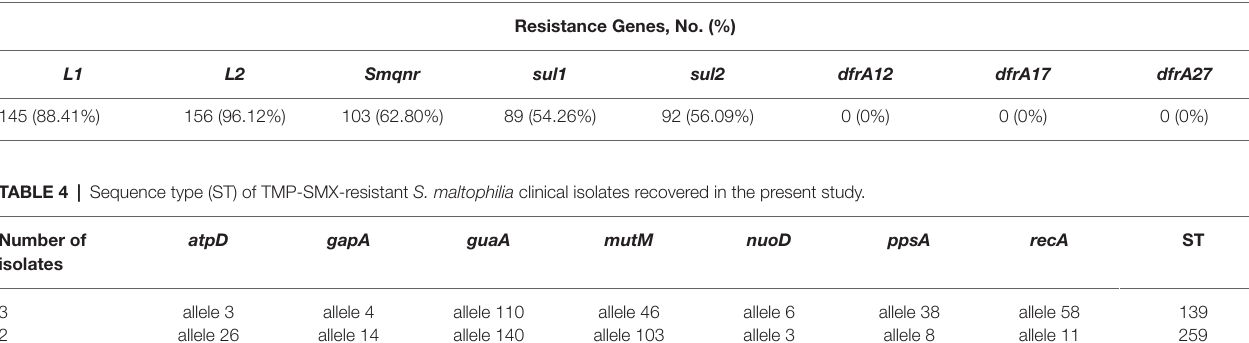
TABLE 3 | Prevalence of resistance genes among 164 S. maltophilia strains isolated from Iran.